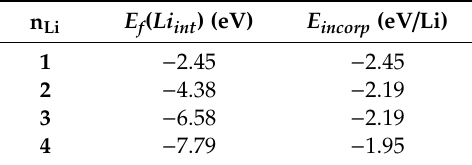
Table 3. Formation energy of a Li interstitial defect, and Li incorporation energy for di ff erent numbers of Li (n Li ) in